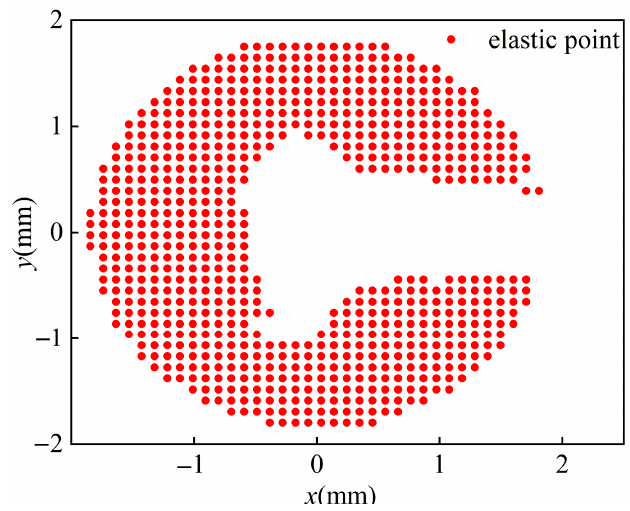
Figure 8. Theoretical plastic zone diagram.